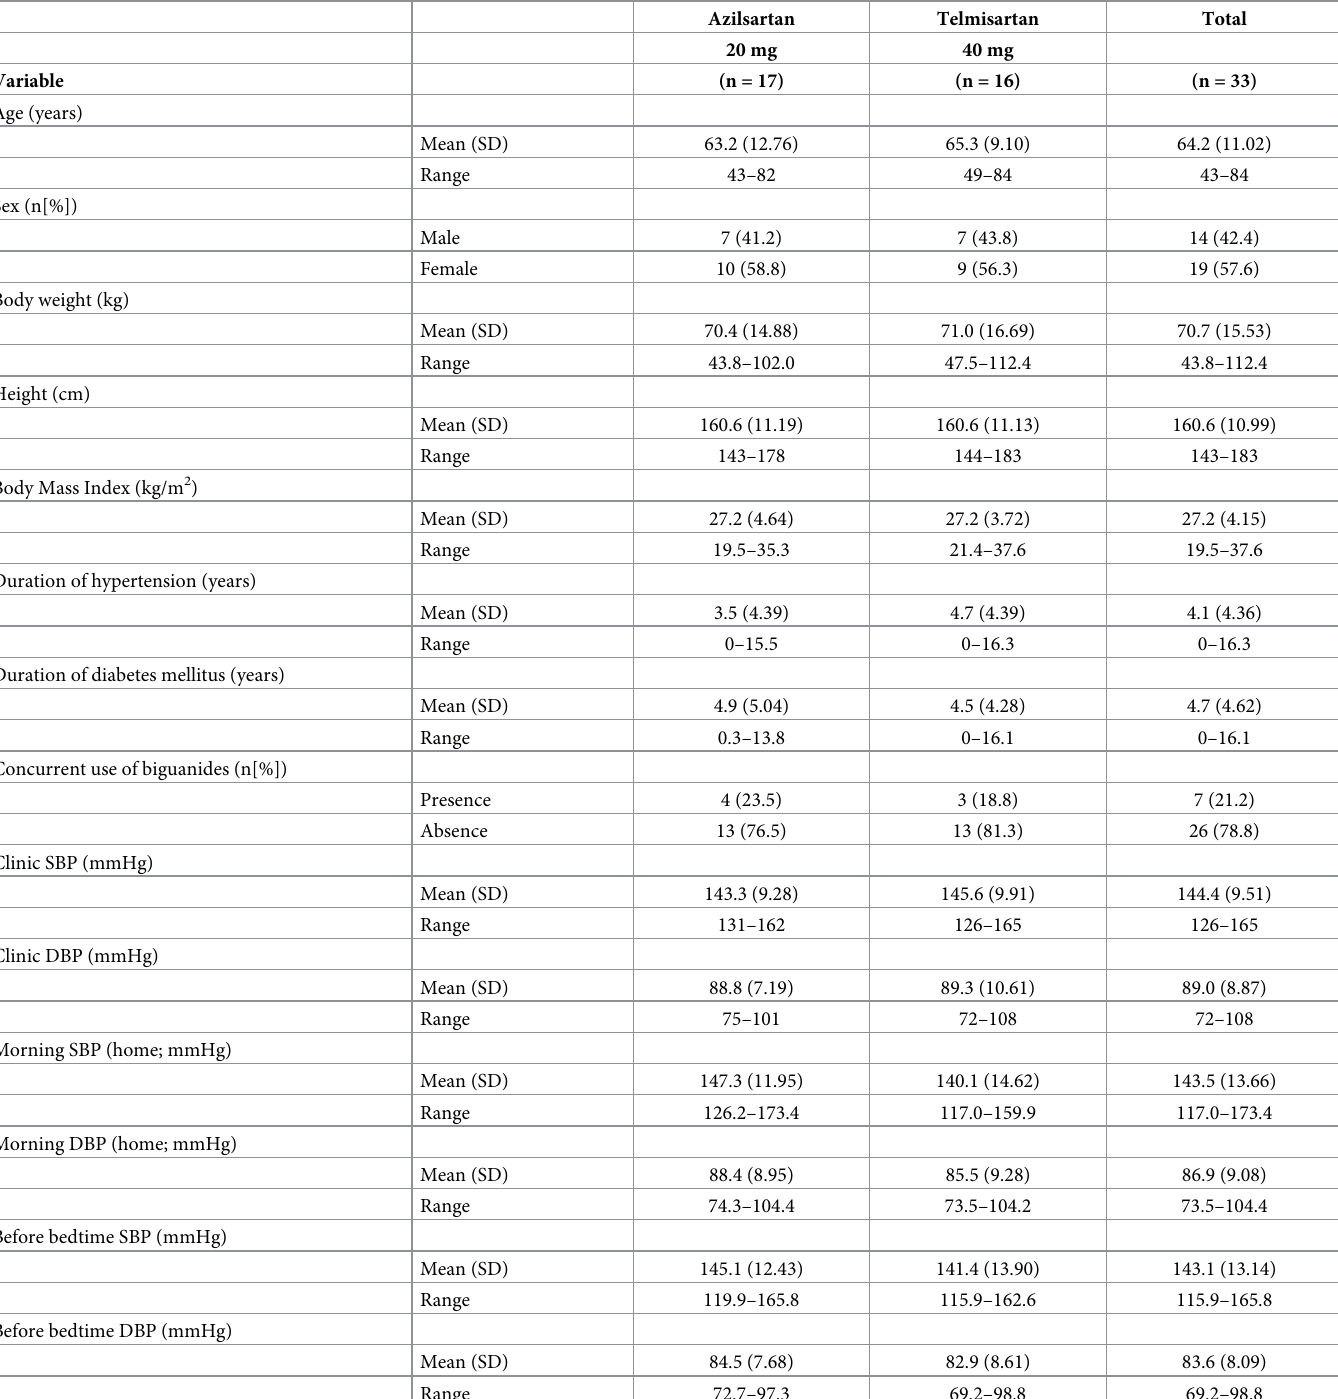
Table 1. Demographic and baseline characteristics of patients